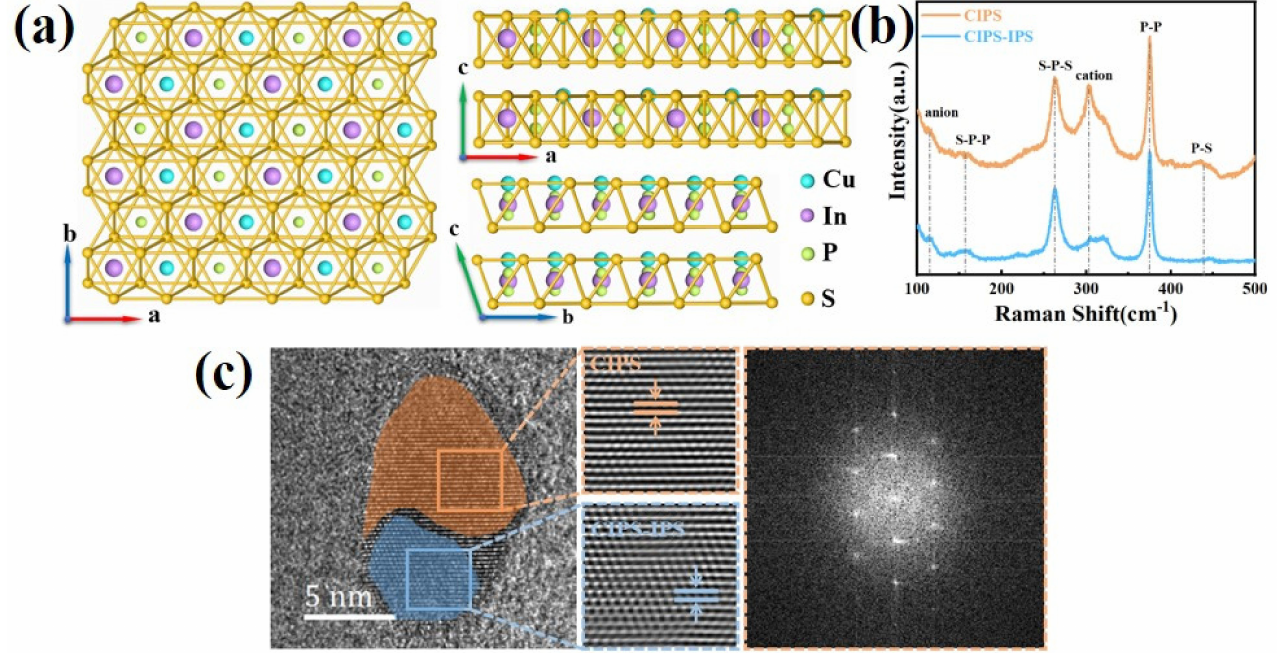
Figure 1. Material characterization of CIPS flake. ( a ) Top and side views of the CIPS crystal structure. In the atomic model, the yellow networks are S triangular networks, and the green, purple, and blue balls are P, In, and Cu atoms, respectively. ( b ) Raman spectra of CIPS flakes, including ferroelectric and paraelectric phases on the Pt substrate with 532 nm laser excitation. ( c ) The TEM characterizations of CIPS crystal include fast Fourier transform (FFT, right ) and filtered inverse FFT ( middle ) patterns of the selected areas,